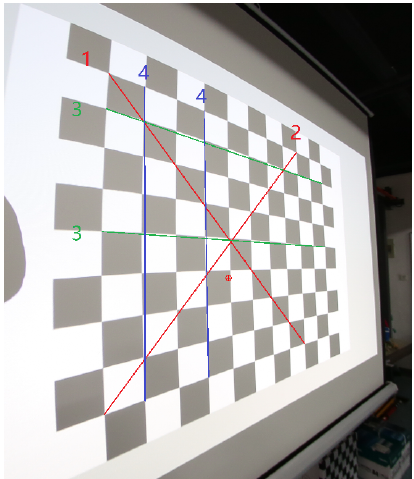
Figure 3: Four directions for evaluating lens correction ( ⊕ repre- sents distortion center)